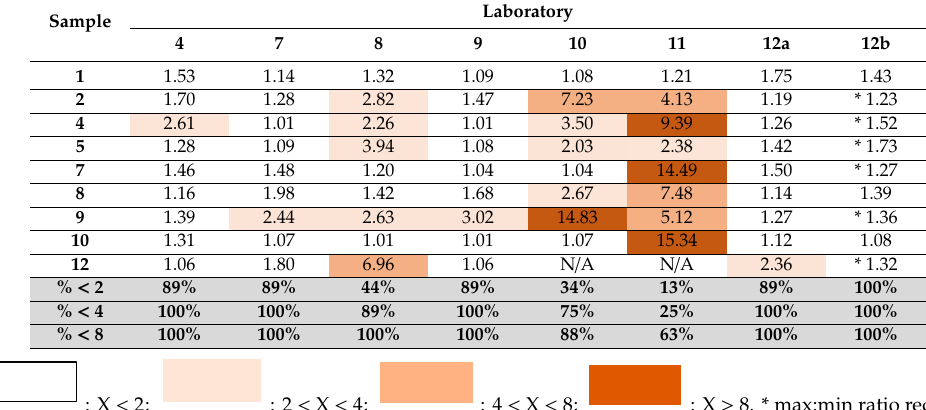
Table 3. Fold-change of laboratory geometric mean potency estimates from the overall median potency estimate for each sample.